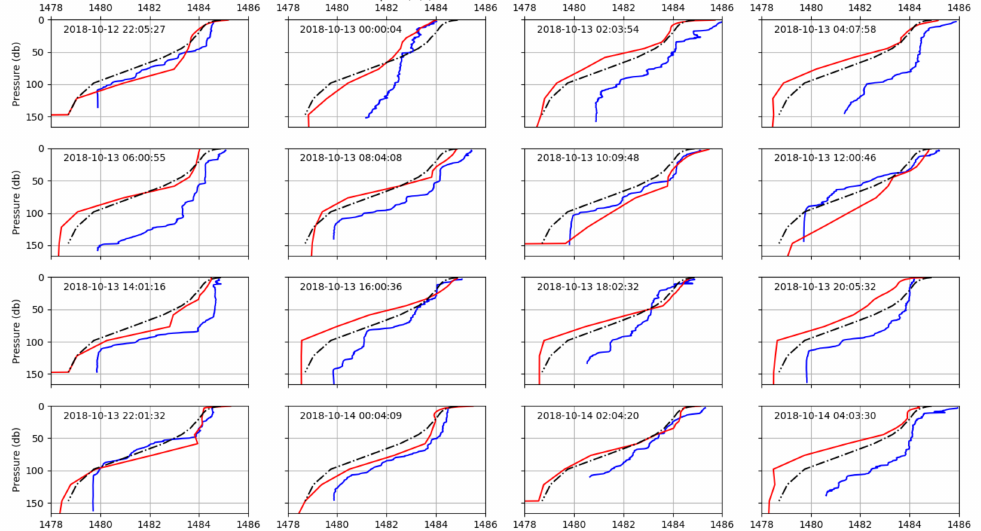
Figure 5. Sound speed profiles observed in the vicinity of the Sooke mooring at the UTC times indicated in each panel (blue lines), derived from CTD casts made on transects past the mooring between 22:00 12 October to 06:00 14 October (UTC), 2018. Also shown are sound speed profiles as obtained from the SalishSeaCast model at the nearest grid point and nearest time (red lines) to the measured data. The broken black lines show the average modeled sound speed profile for this period during the experimental source